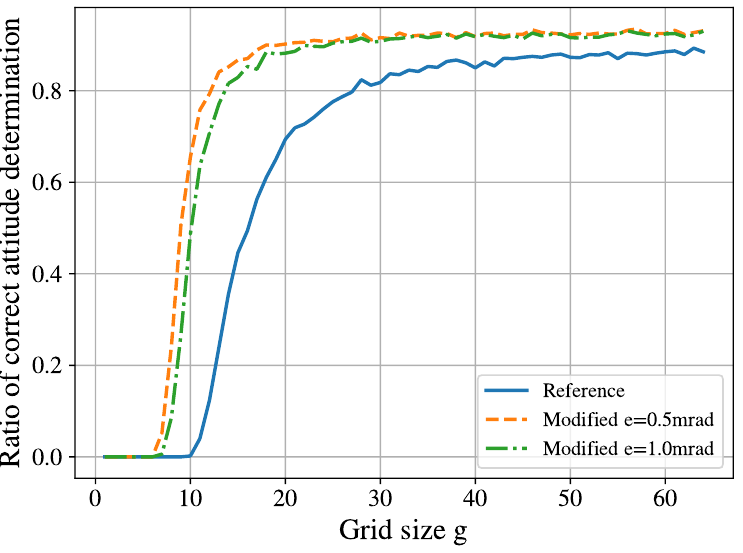
Figure 6. Ratio of correct attitude quaternion determination for different grid sizes. Here, a field of view of 8° is